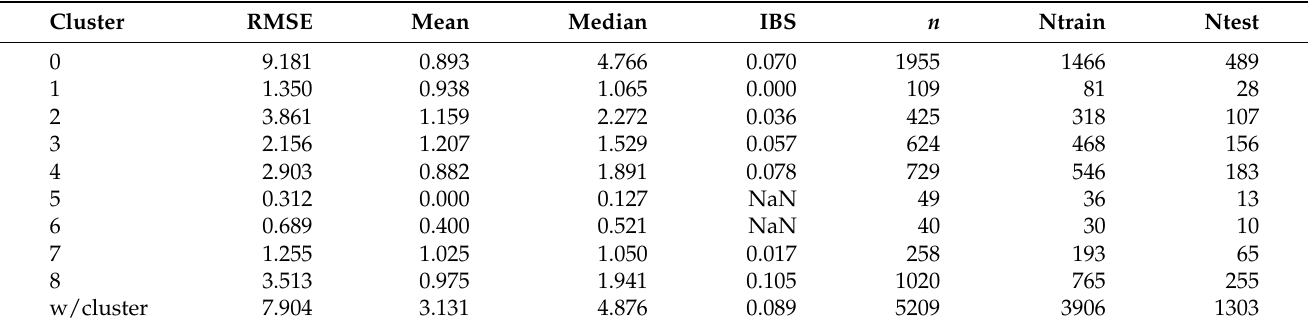
Table 7. Brier Score performance prediction in each